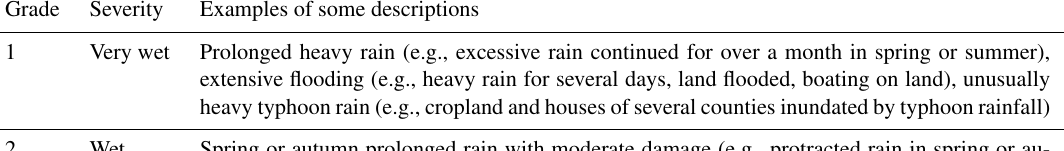
Table 1. Dryness–wetness index in China. Grade